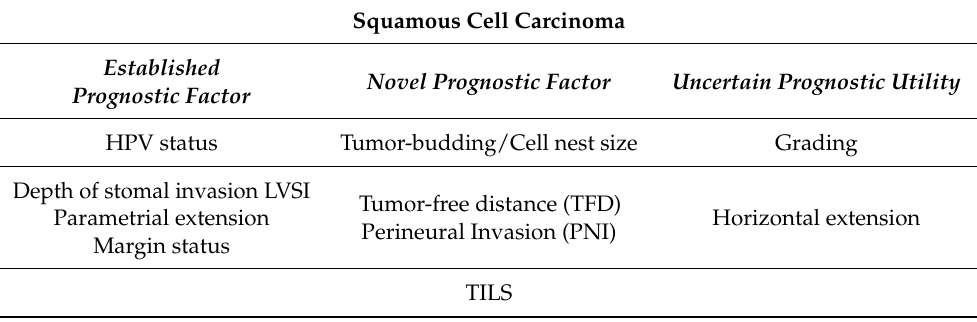
Table 1. Prognostic factors related to primary tumors: squamous cell carcinoma.